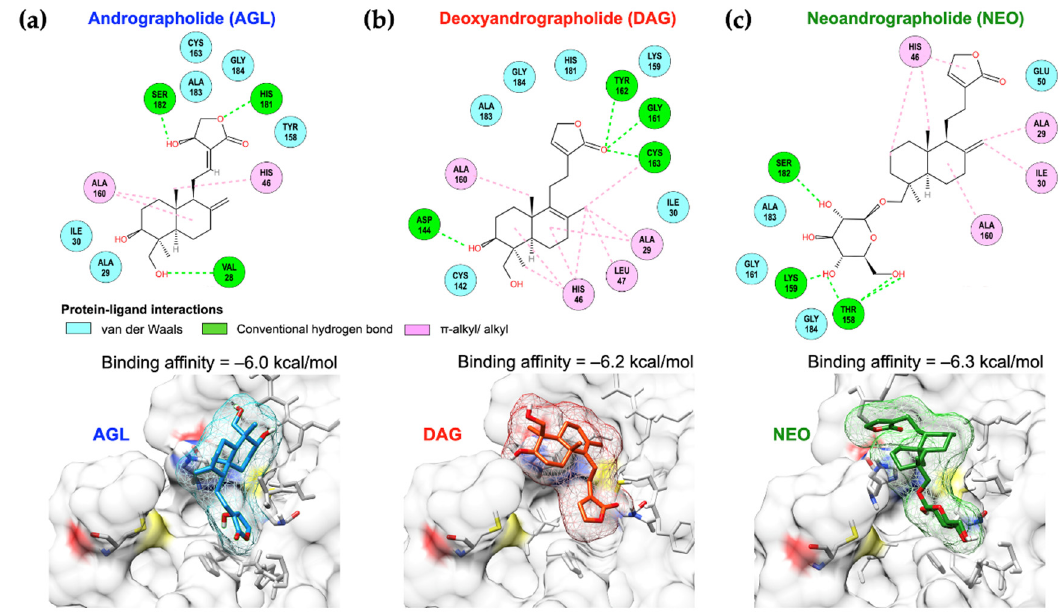
Figure 5. Molecular docking of FMDV 3C pro and protein-ligand interactions of AGL ( a ); DAG ( b ); and NEO ( c ) with the binding pocket of FMDV 3C pro in 2D (upper panel) and 3D structures (lower panel). The binding affinities of AGL, DAG, and NEO are presented on the top of the lower panel, respectively.